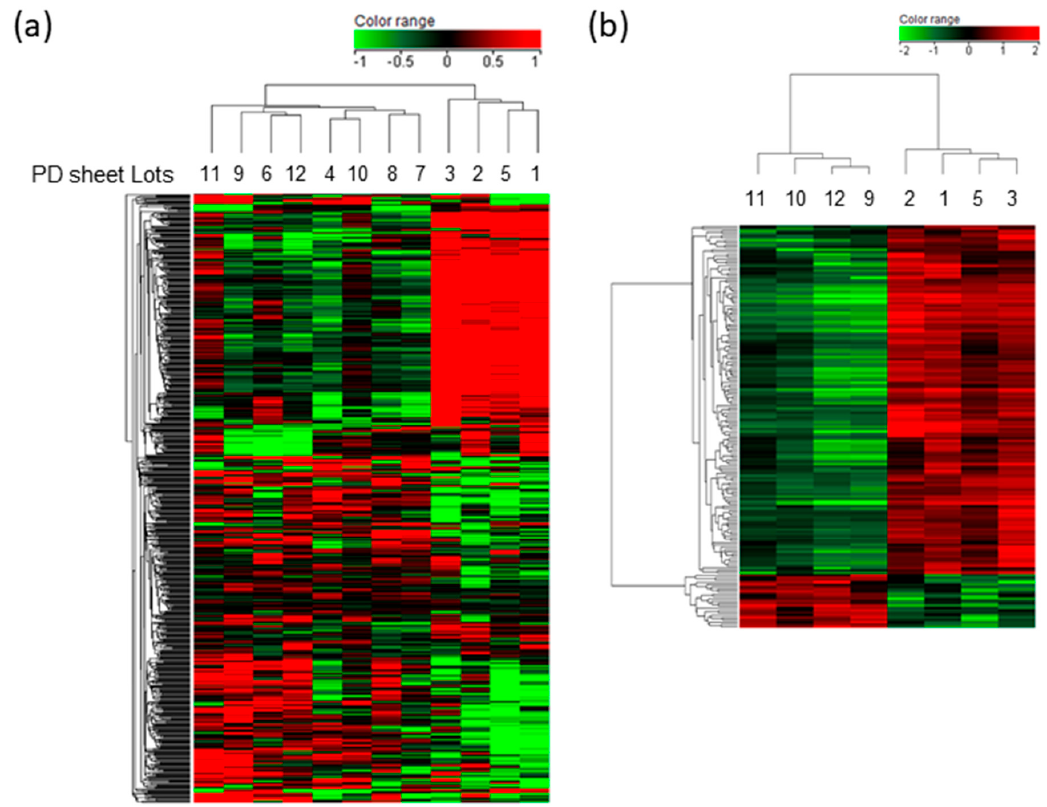
Figure 2. Heat map and hierarchical clustering of efficacy-correlated gene expressions: PD sheets exhibited a distinct gene expression profile according to their in vivo efficacy. Red indicates high expression levels, and green represents low expression levels. ( a ) Analyzed using efficacy correlated 443 gene set. ( b ) Differentially expressed 171 genes in effective and less effective lots of PD sheets.